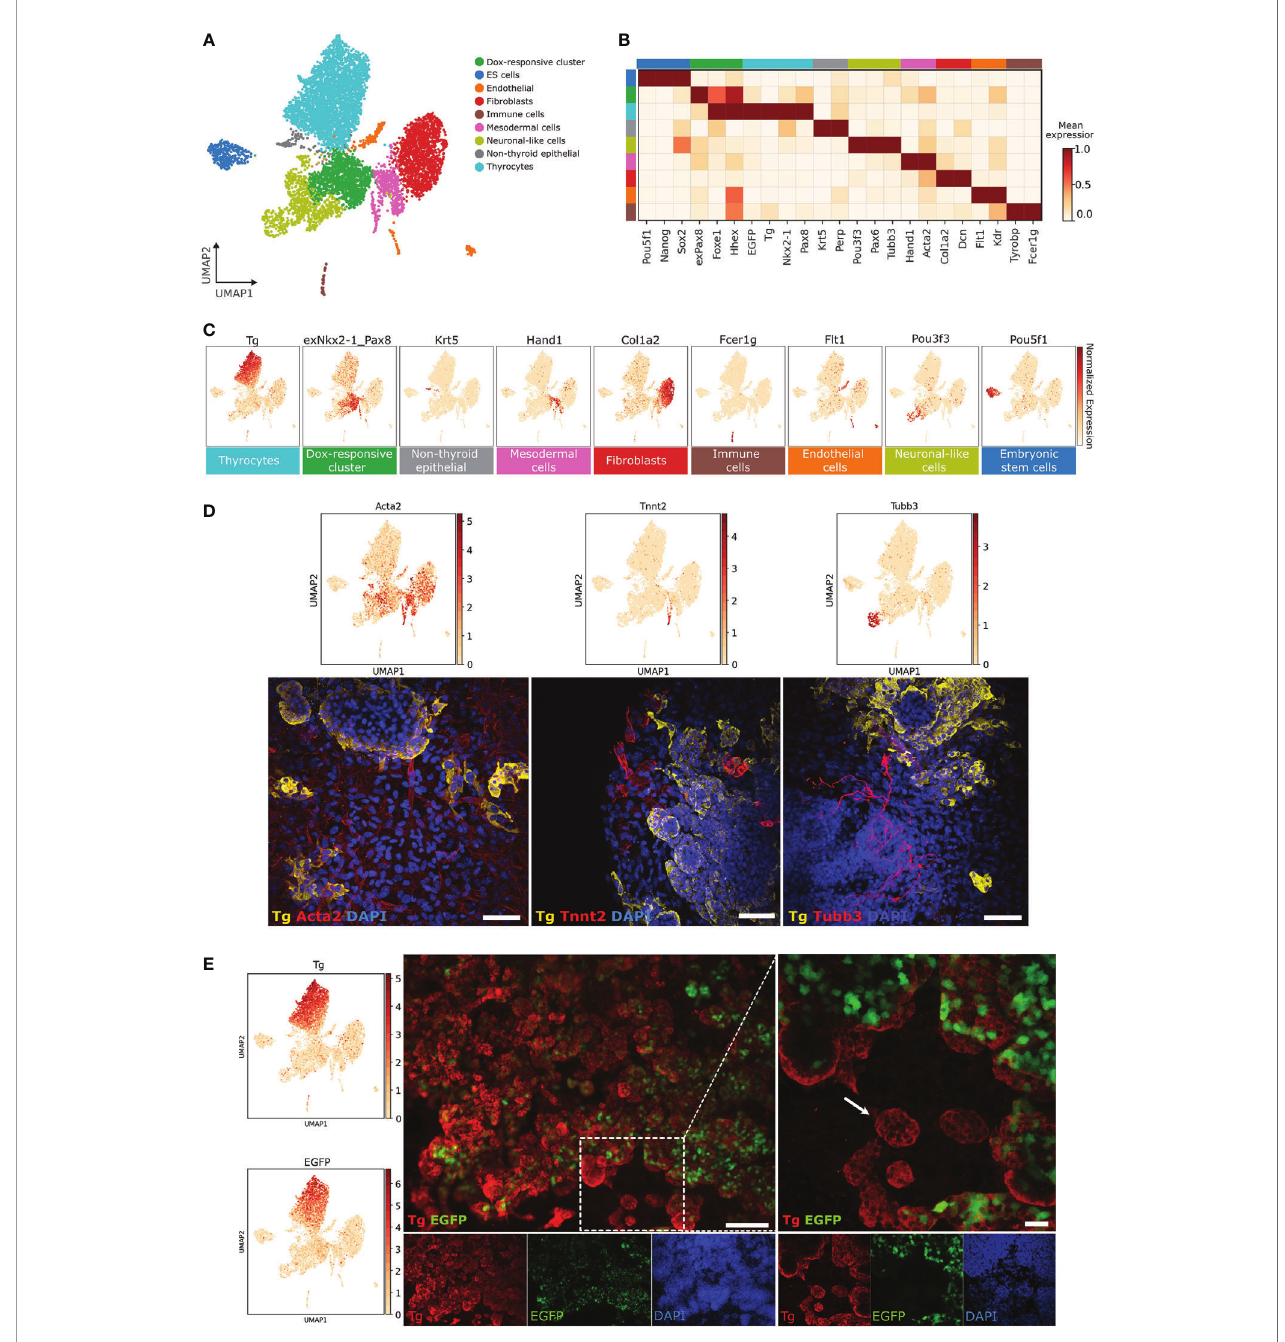
FIGURE 2 | Characterization of cell types present in thyroid organoids. (A) Unsupervised clustering of in vitro thyroid organoid model. Each cluster is represented by a speci fi c color. (B) Gene-expression matrix plot for selected marker genes for each cell cluster. Rows depict cell clusters, while columns depict genes. The intensity of color in each square indicates mean expression within the cluster. (C) UMAP expression plots of representative marker genes for thyrocytes ( Tg ), Dox-responsive cluster (exNkx2-1_Pax8), Non-thyroid epithelial cells 1 ( Krt5 ), Mesodermal cells ( Hand1 ), Fibroblasts ( Col1a2 ), Immune cells ( Fcer1g ), Endothelial cells ( Flt1 ), Neuronal- like cells ( Pou3f3 ) and Embryonic stem cells ( Pou5f1 ). Color intensity indicates normalized expression of respective genes. (D) Immuno fl uorescence-based detection of speci fi c non-thyroid cell-types at differentiation day 22. For mesenchymal cell population, fi broblasts were labeled with smooth muscle actin ( Acta2 ; red) while cardiomyocytes were marked with Troponin T ( Tnnt2 ; red). Thyroid follicles were labeled with antibody against Thyroglobulin ( Tg ; yellow). Neurons were con fi rmed by staining for beta-III tubulin ( Tubb3 ; red). (E) To evaluate the extent of bovine Tg promoter driven GFP expression in thyroid follicular cells, organoid culture at differentiation day 22 was stained for Tg (red). A fraction of Tg-expressing cells do not express EGFP (Zoomed right fi gure; arrow shows Tg + EGFP- follicle). Scale bars: 100 µm and 20 µm